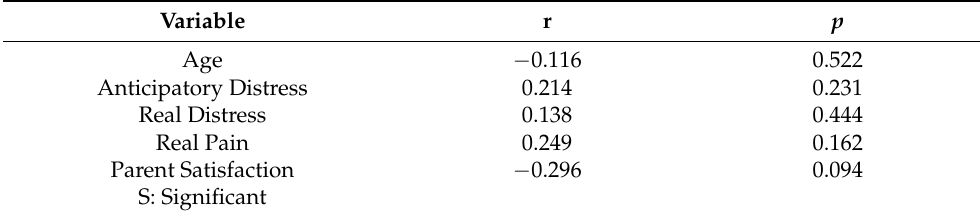
Table 3. Spearman’s correlation coefficient. Anticipatory pain.